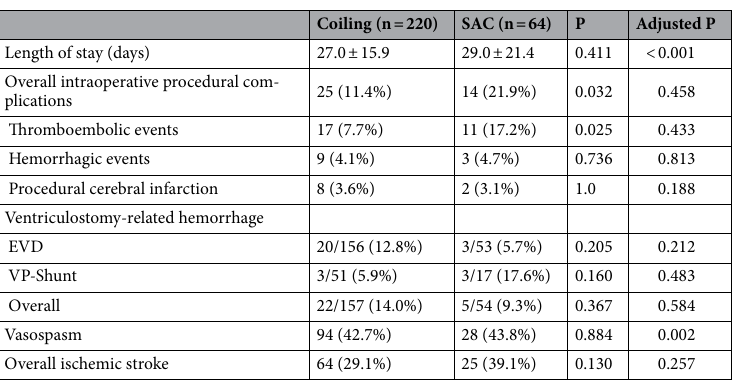
Table 2. Procedure-related complications. SAC, stent-assisted coiling; EVD, external ventricular drain; VP,